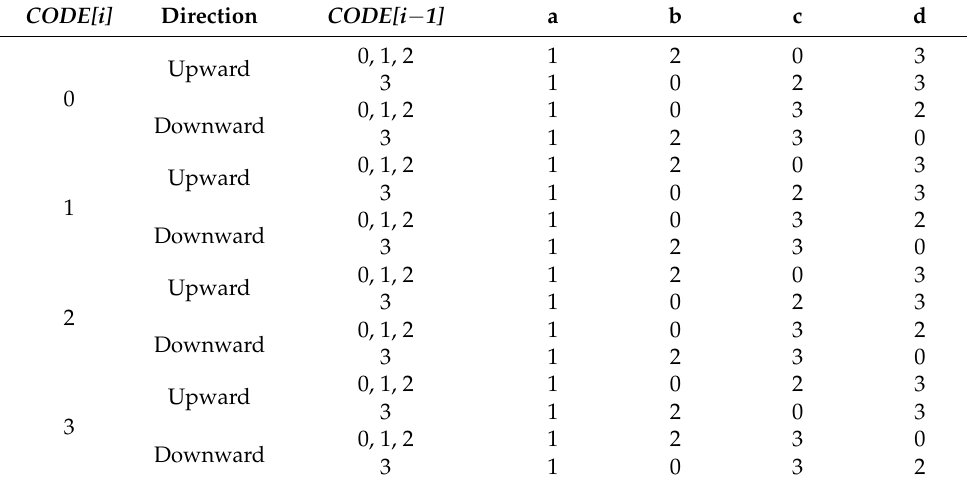
Table 3. Quaternary division encoding rule of QTM based on quaternary